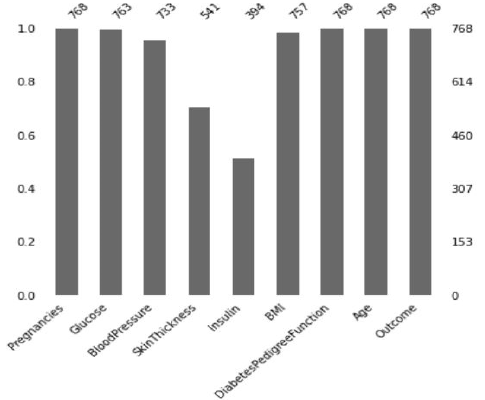
Figure 4. Representation of the missing values before the imputation.